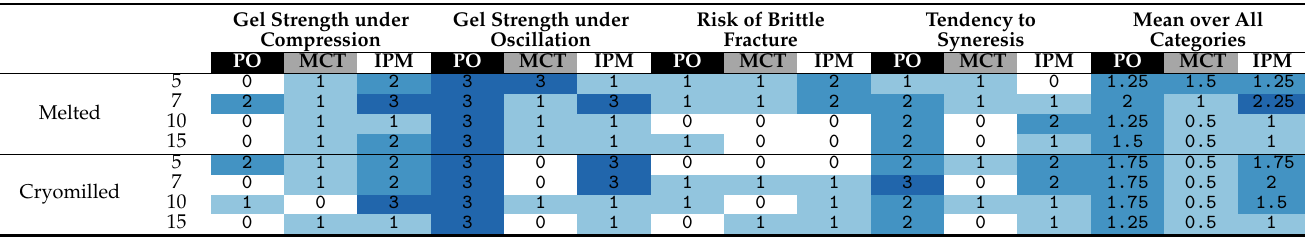
Table 7. Color-coded evaluation of gel wafer parameters (An explanation of the meaning of each color can be found in Table